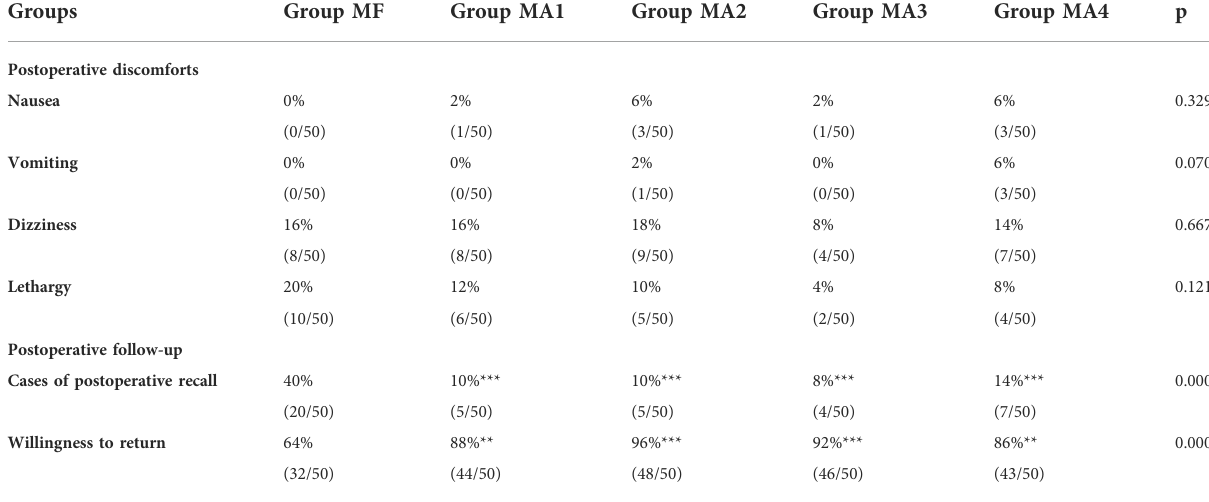
TABLE 5 Comparison of the fi ve groups with regard to postoperative follow-up (n =